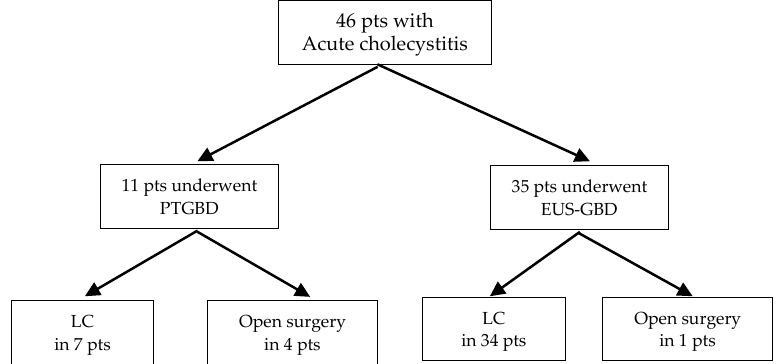
Figure 1. Result of analyzed patients (pts) with acute cholecystitis.